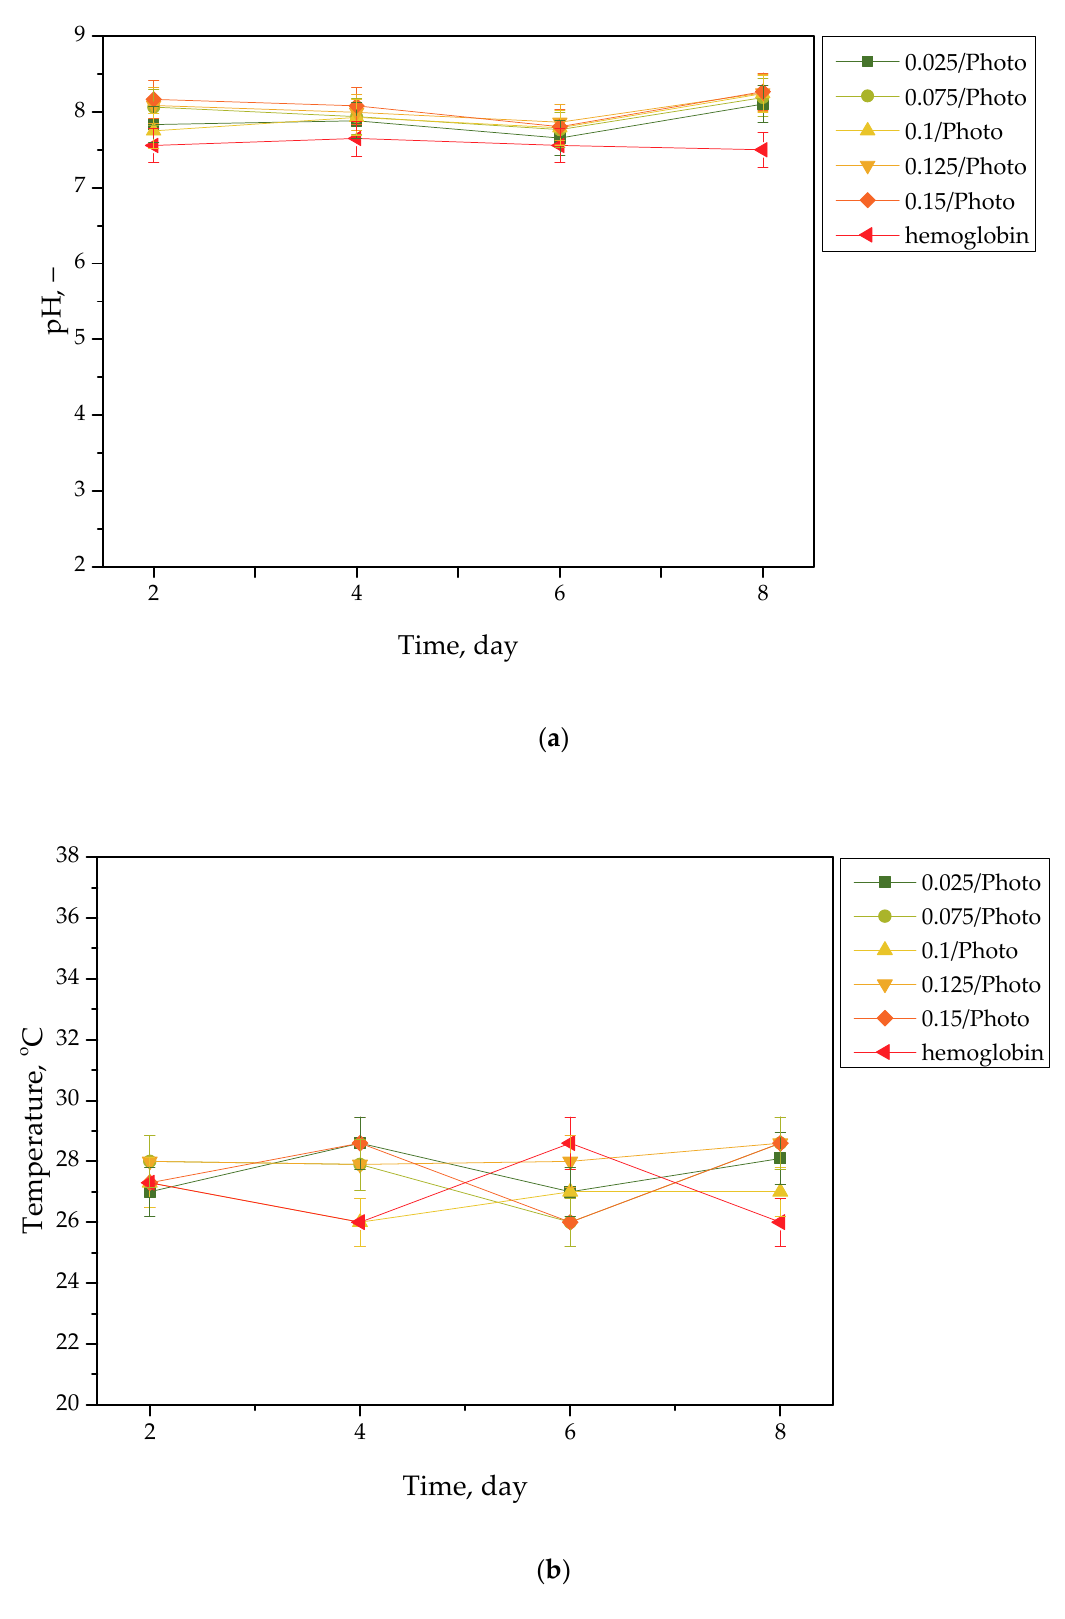
Figure 2. pH ( a ) and temperature ( b ) values of hemoglobin, measured during the hydrogels’ incubation period (n = 3, n—number of repetitions).